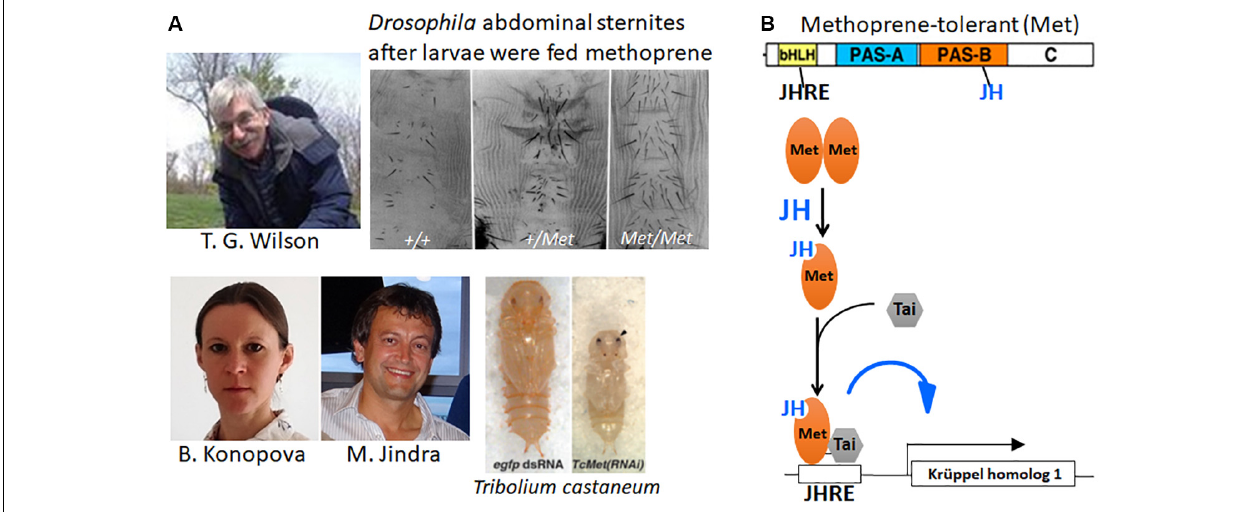
FIGURE 6 | (A) Top: (Left) Tom Wilson (photo was taken by Emily Wilson and used with her permission). The adult abdominal sternites of the Methoprene-tolerant ( Met + ) mutant of Drosophila melanogaster after the larvae fed on diet containing methoprene (modified from Figure 2 of Wilson and Fabian, 1986). + / +, homozygous wild type; +/ Met , heterozygous Met mutant; Met / Met , homozygous Met mutant. Bottom : Barbora Konopova and Marek Jindra and the precocious pupa they obtained after giving Met RNAi to a 4th instar larva of Tribolium castaneum (right) compared with a normal pupa that formed after egfp RNAi had been given to a 4th instar larva (left) (modified from Figure 3 in Konopova and Jindra, 2007). Photos of Barbora Konopova from her Research Gate file (used with her permission) and of Marek Jindra taken by Masako Asahina (used with Dr. Jindra’s permission). (B) Top : Cartoon of the Met protein showing its various domains: bHLH, basic helix-loop-helix domain; the Period-Arylhydrocarbon receptor nucleotide translocator-Single-minded (PAS) A and B domains; the C terminal domain. The bHLH domain binds to the juvenile hormone (JH) response element (JHRE) on the target gene promoter; JH binds to the Pas B domains of Met (Charles et al., 2011) and Germ cell-expressed (Gce) [the paralog of Met (Baumann et al., 2010)] (Bittova et al., 2019). Bottom : Cartoon of events occurring when JH enters a target cell. The unliganded Met is thought to exist as a homodimer (Godlewski et al., 2006). When JH is present, it binds to Met causing the dissociation of the dimer and the binding of Taiman (Tai) to Met, then both Tai and Met bind to the JHRE on the promoters of Krüppel homolog 1 (Kr-h1) and other JH target genes (Jindra et al.,